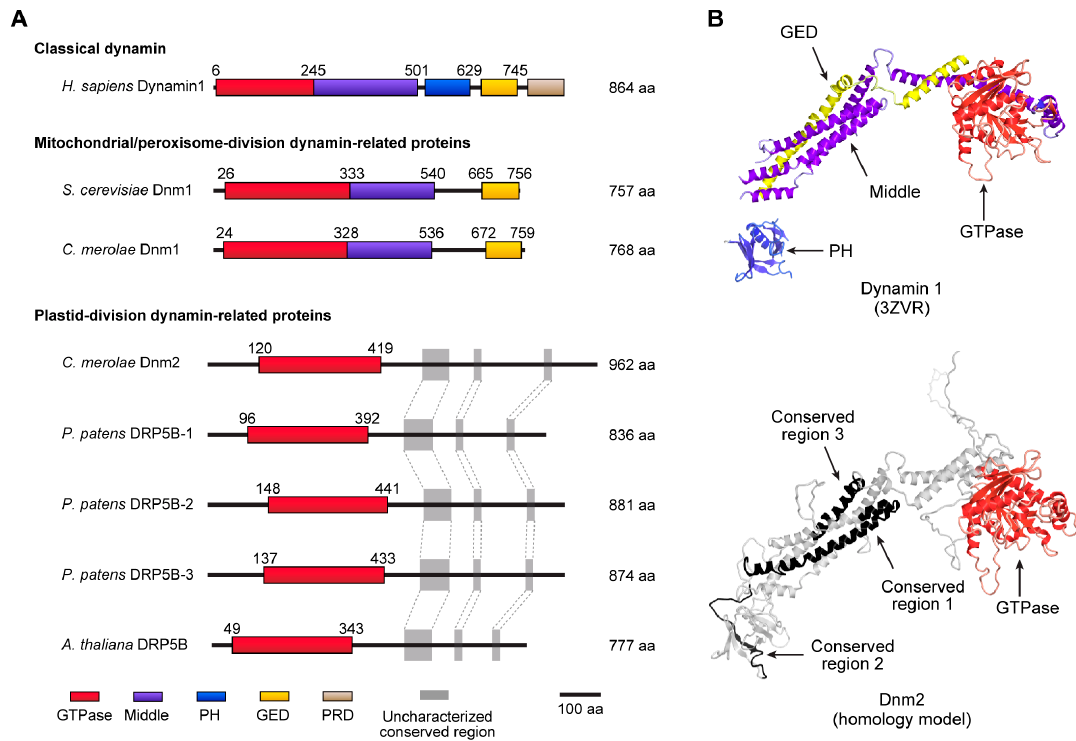
Figure 3. Structures of the dynamin superfamily. ( A ) Domain architectures of the dynamin superfamily. Dynamin 1 catalyzes clathrin-coated vesicle scission at the plasma membrane. Dnm1/DRP1 is involved in the division of mitochondria and peroxisomes. Dnm2 (also known as DRP5B/ARC5 in A. thaliana and moss) is involved in plastid division. GTPase domain (red); middle domain (purple); pleckstrin homology domain (PH, blue); GTPase effector domain (GED, yellow); and proline-rich domain (PRD, light brown). Domain architectures were identified using a conserved-domain search program [48]. ( B ) Protein structures of human dynamin 1 (classical dynamin) for vesicle scission and C. merolae Dnm2 for plastid division. The structure of dynamin 1 is represented with crystal structure data from an assembly-deficient dynamin 1 mutant, G397D Δ PRD (PDB: 3ZVR) [43], while the structure of Dnm2 is visualized using homology modeling based on the dynamin 1 structure. The functional domains in dynamin 1 are shown in red (GTPase domain), purple (middle domain), blue (PH domain), and yellow (GED domain); the proline-rich domain (PRD) is not shown. Uncharacterized conserved regions in Dnm2 are shown in black. The protein structure of Dnm2 was modeled as described in Figure 2.